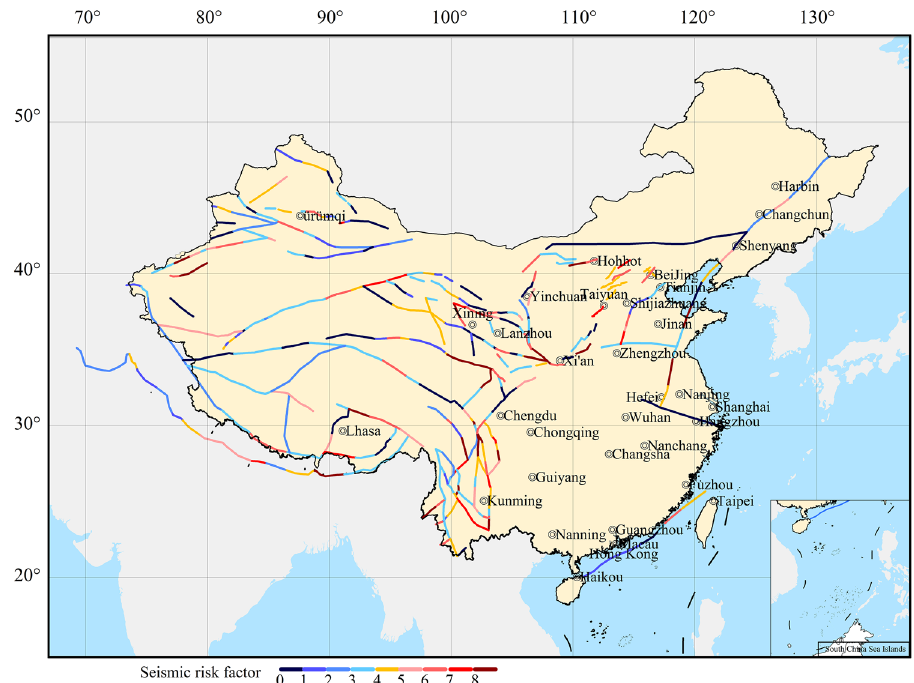
Fig. 3 Seismogenic fault model for China’s mainland (including 391 fault segments; the redder the fault segment, the greater the hazard coefficient, and the bluer the color, the smaller the hazard coefficient). Source data from Shao et al.